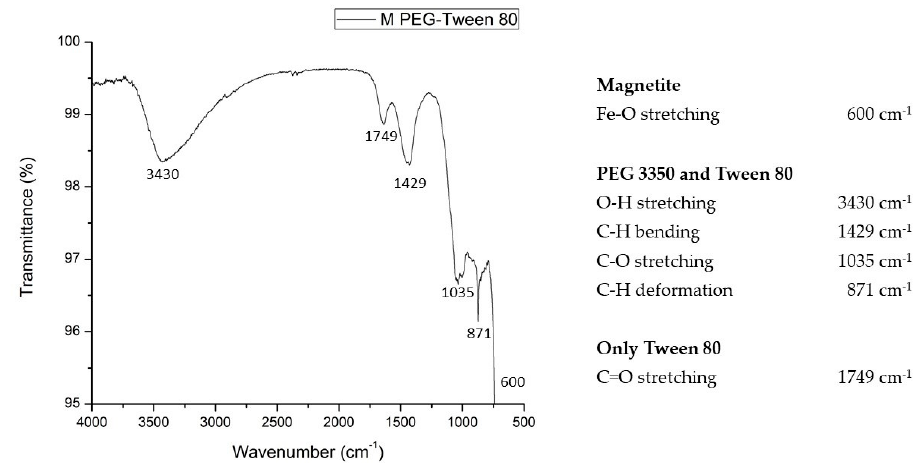
Figure 3. FTIR spectra of magnetite coated with PEG 3350-Tween 80. Obtained bands correspond to bonds found in PEG 3350 as well as in Tween 80: deformation (871 cm − 1 ) and bending (1429 cm − 1 ) vibration of C–H; C–O stretching (1035 cm − 1 ) and the O-H stretching (3430 cm − 1 ). Samples present the Fe–O stretching (600 cm − 1 ) coming from the magnetite and the C = O stretching (1749 cm − 1 ) coming from the Tween 80.